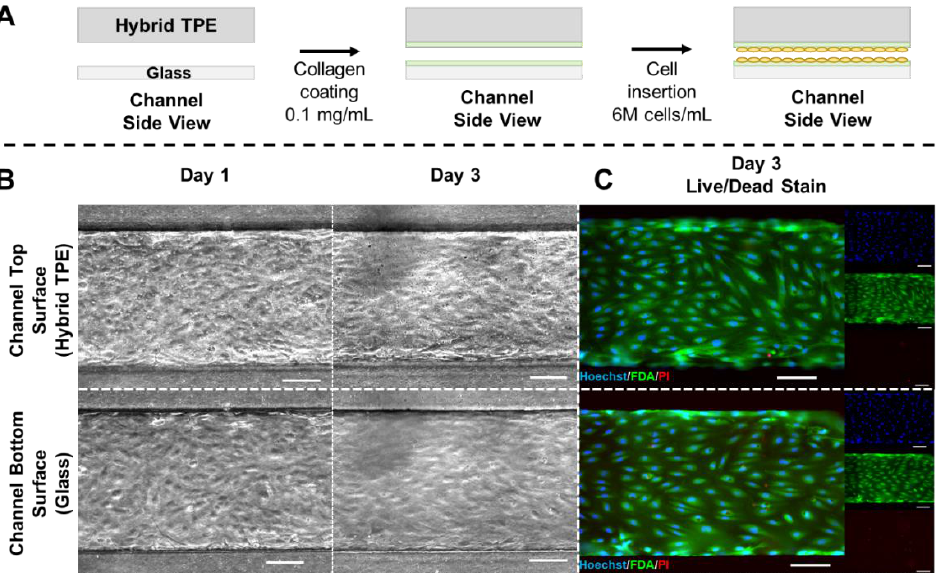
Figure 4. ( A ) Schematic depiction of cell culture experimental steps. The PC/TPE-hybrid–glass device is initially coated with type I collagen. Excess collagen is flushed out and followed by HUVEC seeding. The chip is temporarily flipped during cell seeding to ensure cell adhesion to both sides of the channel. ( B ) Micrographs acquired using phase contrast microscopy show cell attachment and progression of the cell culture from day 1 to day 3 for both substrates (left). ( C ) Fluorescence microscopy images from the live/dead staining (Hoechst/FDA/PI) on day 3 (left: composite image; right: individual color channels). Scale bars: 100 µm. N = 3.